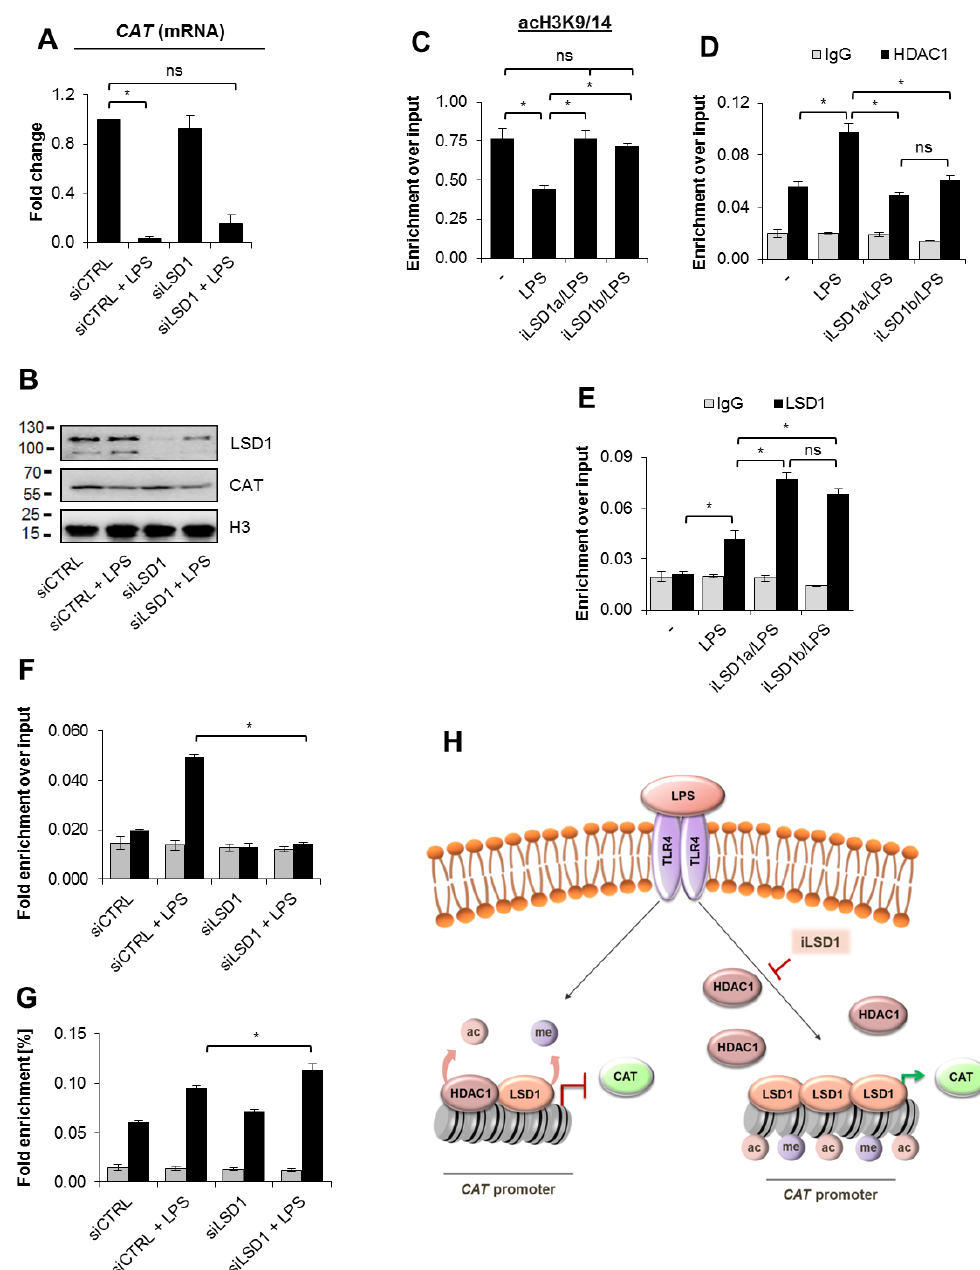
Figure 5. LSD1 activity allows for HDAC1 recruitment to the CAT promoter and the gene repression in cells stimulated with LPS. The impact of LSD1 deficiency on the CAT transcription was studied in LSD1 transient knock downs (siLSD1) and corresponding control cells (siCTRL) by real-time PCR ( A ) and Western blot ( B ) 48 h after cell transfection. The effect of LSD1 inhibition on chromatin composition ( C , D ) and histone acetylation ( E ) in cells activated with LPS for 12 h was studied by ChIP-qPCR. iLSD1a (0.1 µ M SP2509) and iLSD1b (0.1 µ M GSK-LSD1) were added for 2 h prior to cell treatment with 10 ng/mL LPS. The recruitment of LSD1 and HDAC1to the CAT promoter in normal and LSD1-deficient macrophages stimulated with LPS was monitored by ChIP-qPCR ( F , G ). ( H ) Graphical presentation of the possible cross-talk between LSD1 activity, HDAC1 recruitment to the CAT promoter, chromatin structure (histone acetylation) and the CAT transcription. Inhibition of LSD1 activity enhances the binding of demethylase but interferes with the recruitment of HDAC1 upon macrophage stimulation with LPS. Western blots show representative images from three independent experiments. Bars in the figures represent mean ± standard error of the mean (SEM). One-way analysis of variance (ANOVA) was carried out in GraphPad Prism 5 to compare means in several groups and the differences between each of the two groups were tested with the Tukey post hoc test (marked with * when P < 0.05, with ns when P > 0.05).